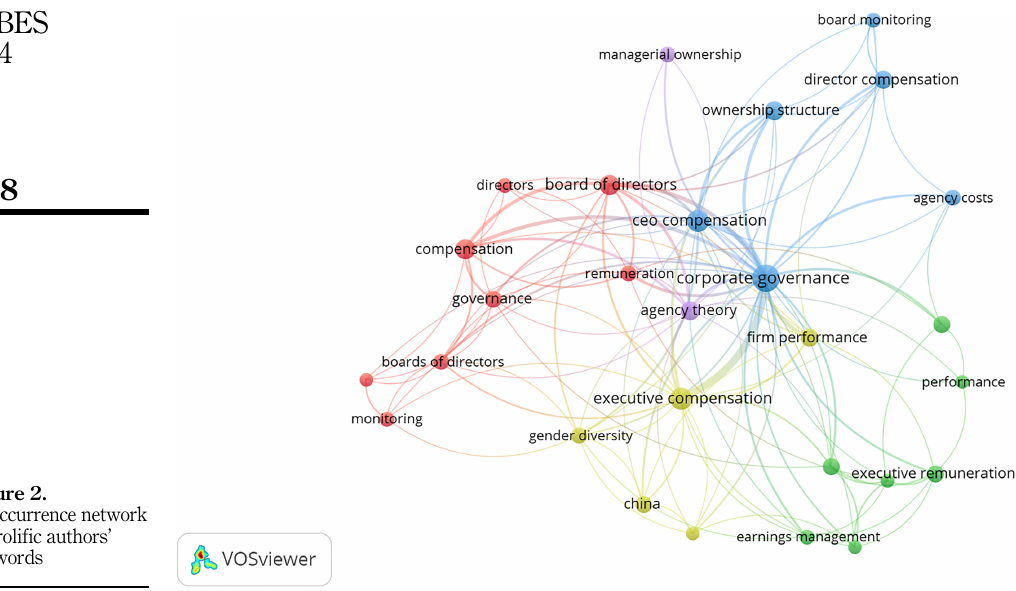
Figure 2. Co-occurrence